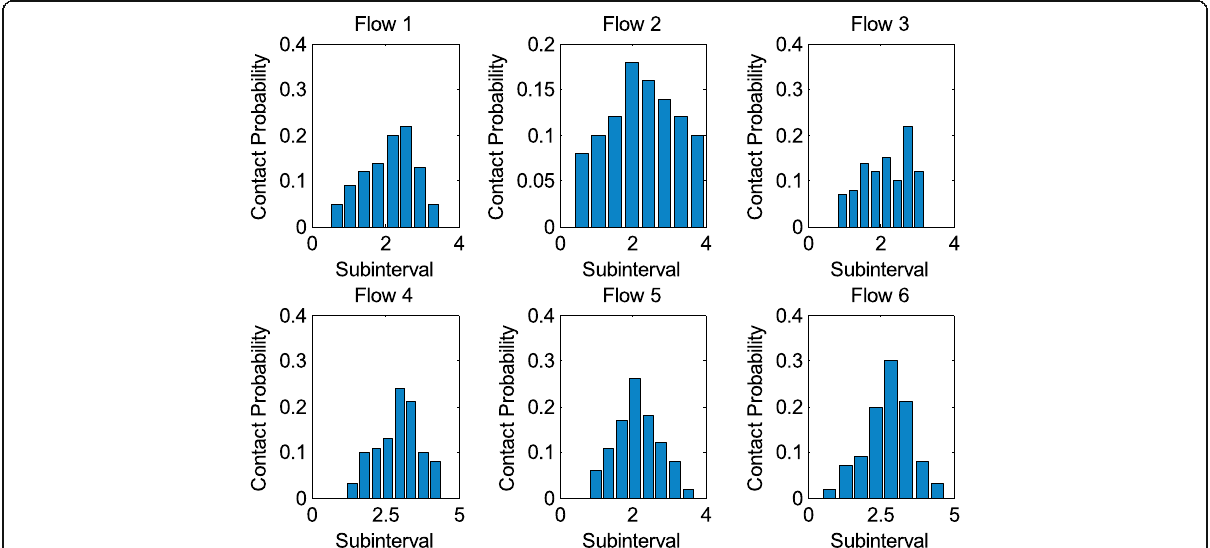
Fig. 7 Probability distribution of contact between upstream SU and bottleneck SU under different per-link flows when the number of subintervals M =